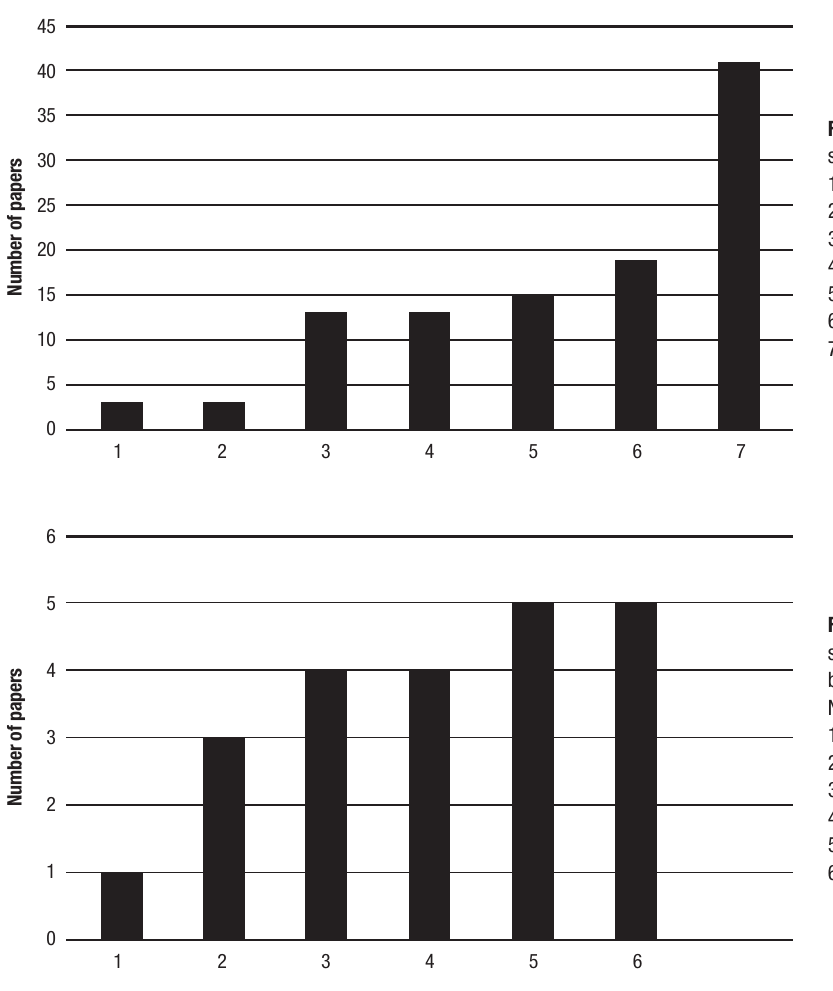
Figure 2. Number of papers by